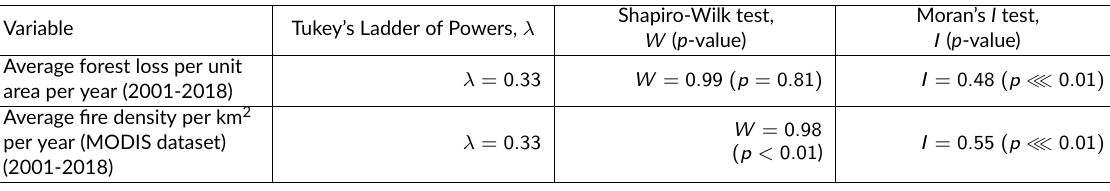
Table S1 – Transformation parameters and normality test results for forest loss and fire